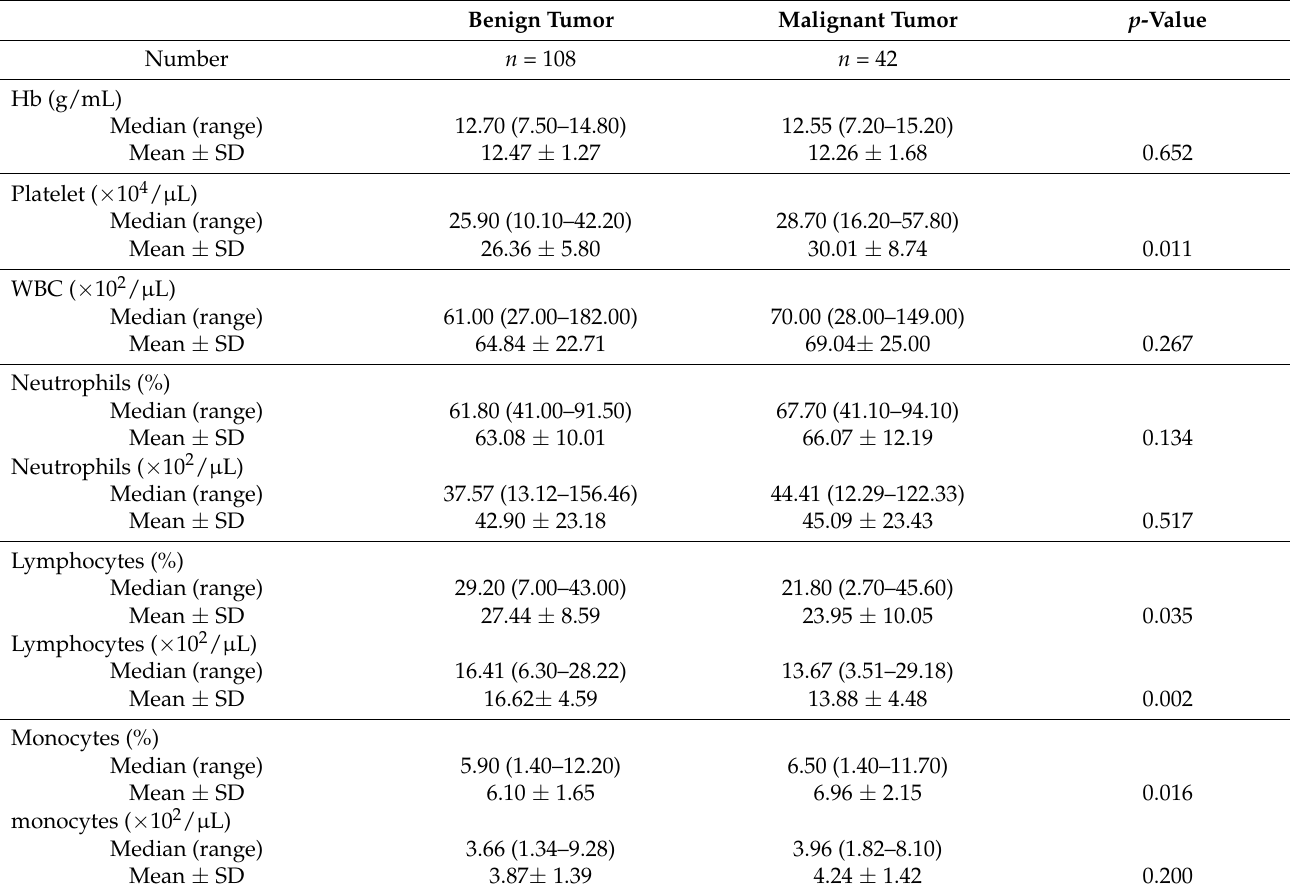
Table 2. Distributions of peripheral blood cells and serum inflammatory values in the current